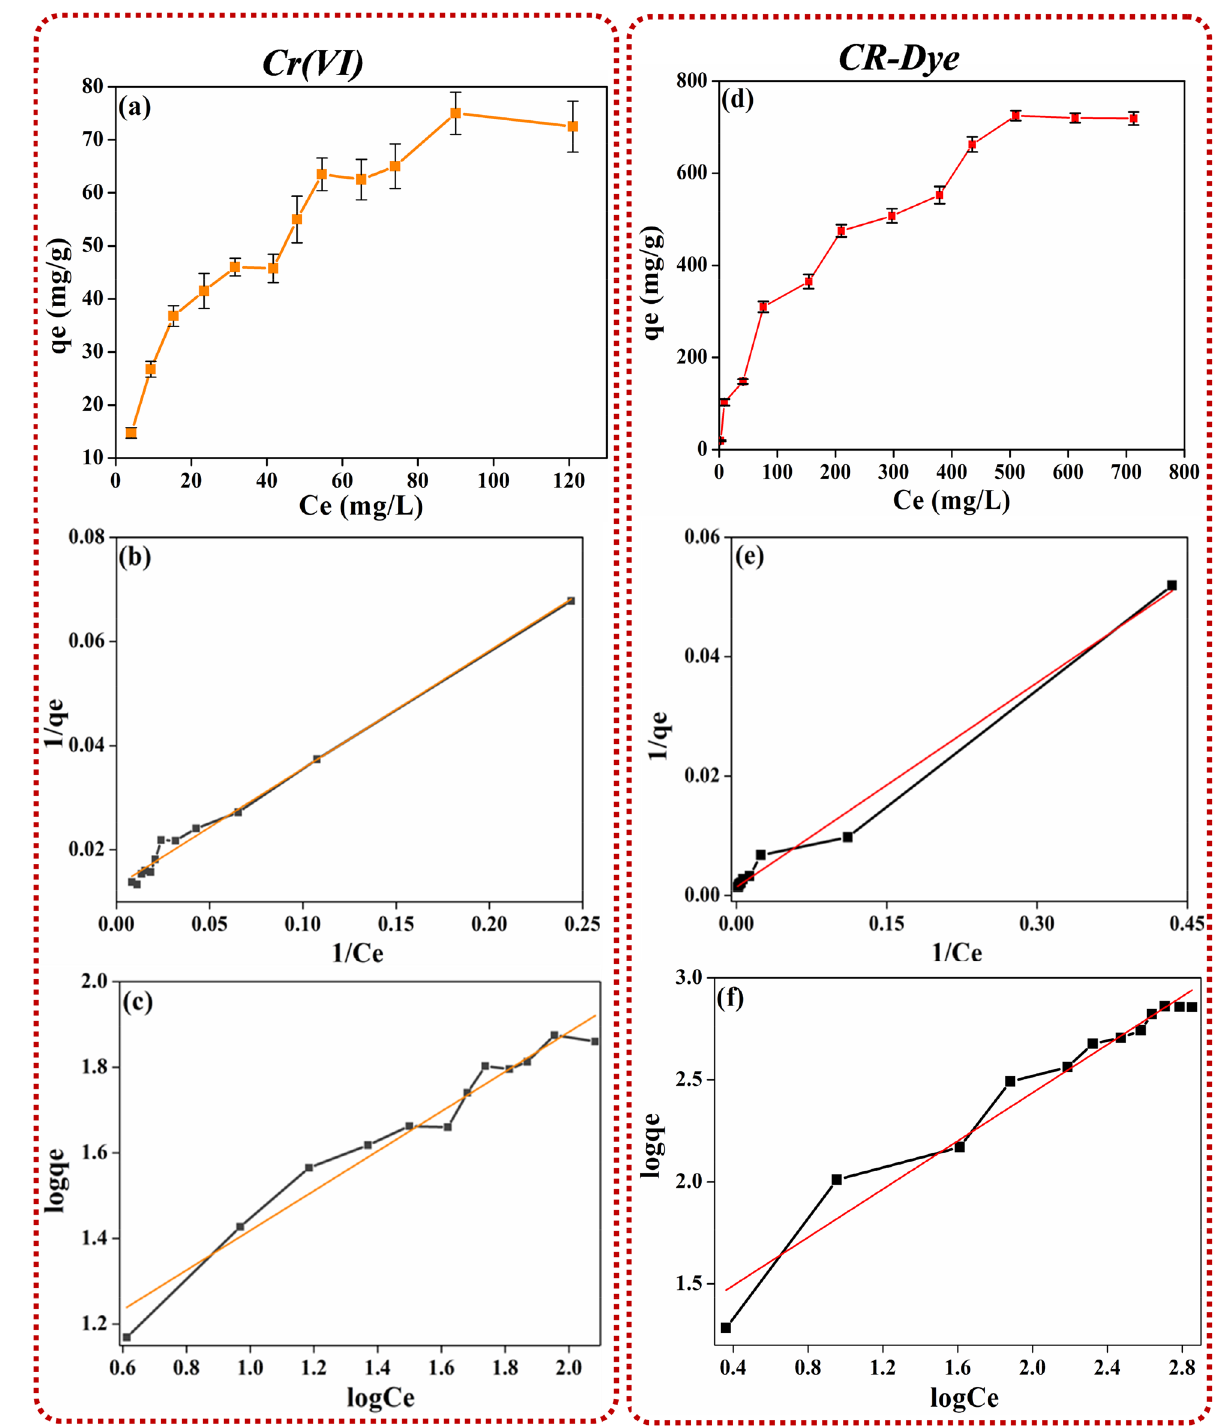
Figure 7. Effect of liquid phase concentration of ( a – c ) Cr(VI) adsorption ( d – f ) CR-dye adsorption. ( a ) Adsorption Isotherm, ( b ) Langmuir isotherm, ( c ) Freundlich isotherm, ( d ) Adsorption isotherm, ( e ) Langmuir isotherm, and ( f ) Freundlich